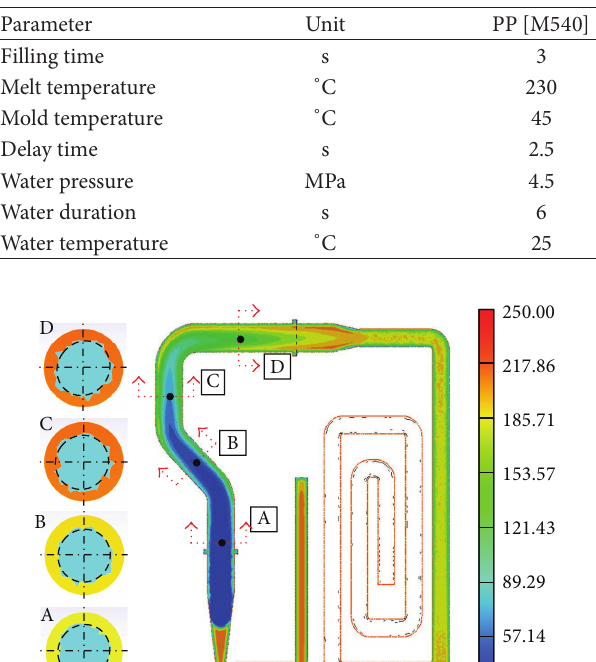
Table 1: Process conditions for WAIM simulation analysis.